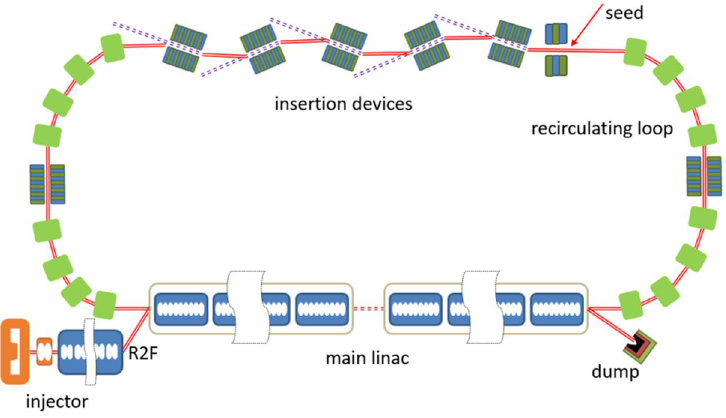
Figure 7. Schematic layout of a 3 GeV single turn ERL light source.